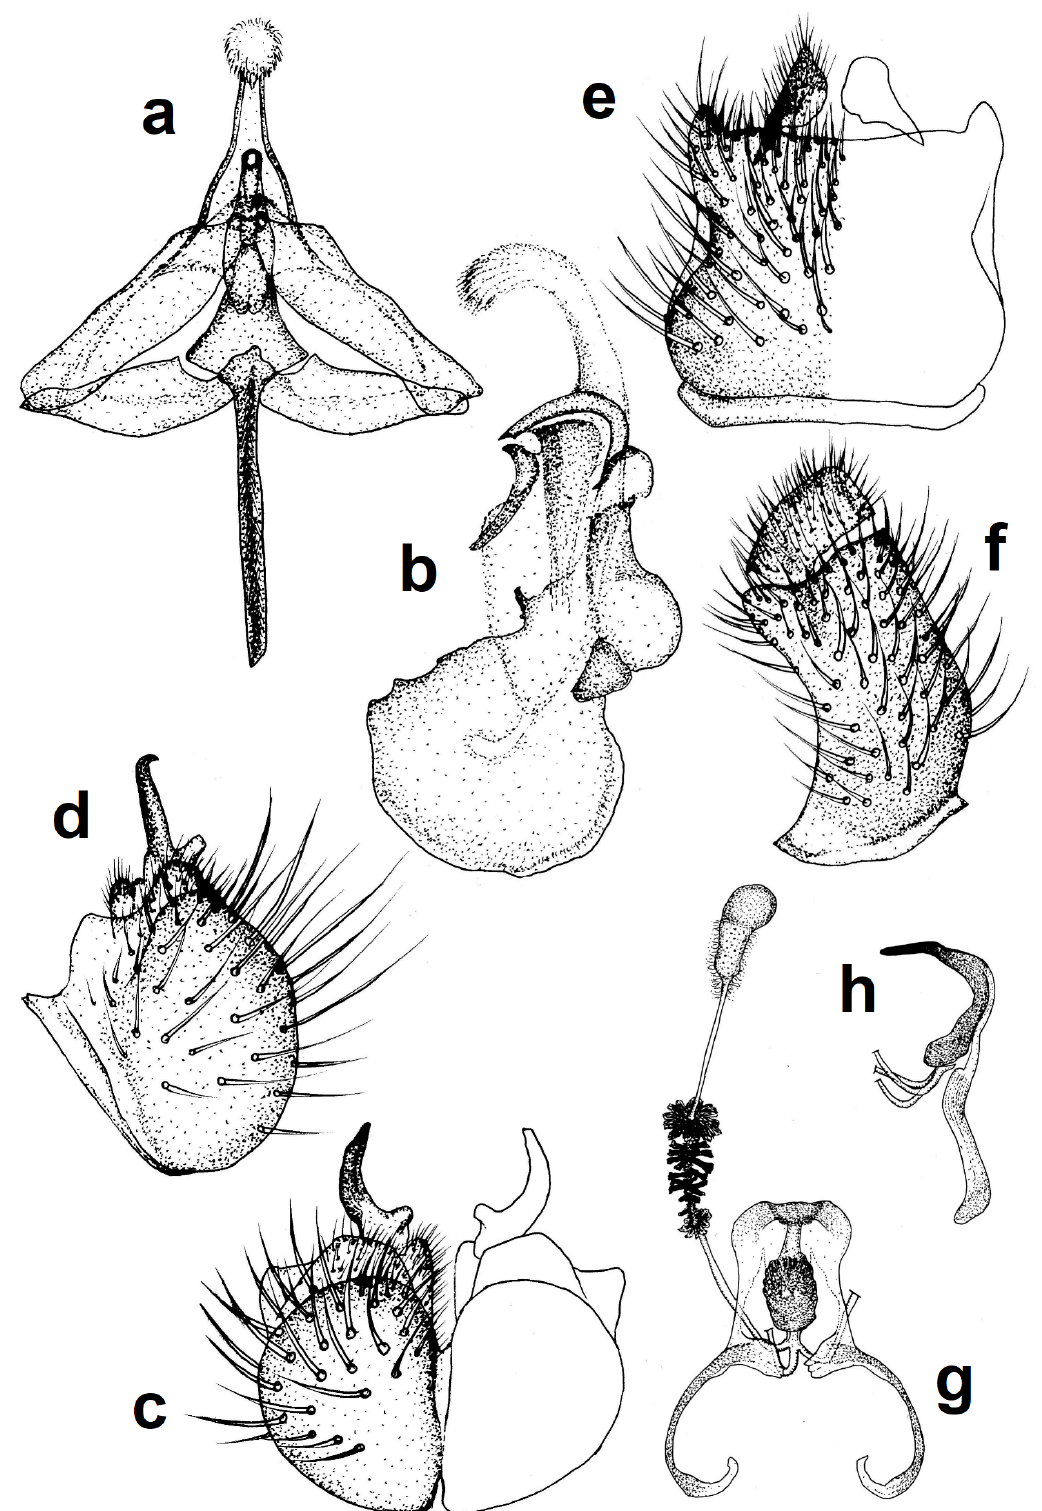
Fig. 56. Protypusia strymonas gen. et sp. nov. a . Epiphallic complex ventral. b . Epiphallic complex lateral. c . Gonocoxite ventral. d . Gonocoxite lateral. e . Epandrium dorsal. f . Epandrium lateral. g . Female genitalia ventral. h . Female genitalia